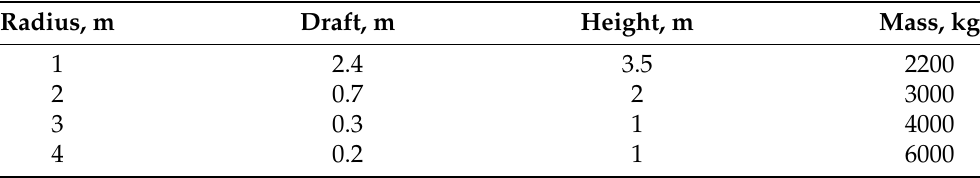
Table 2. Buoy dimensions used for the two